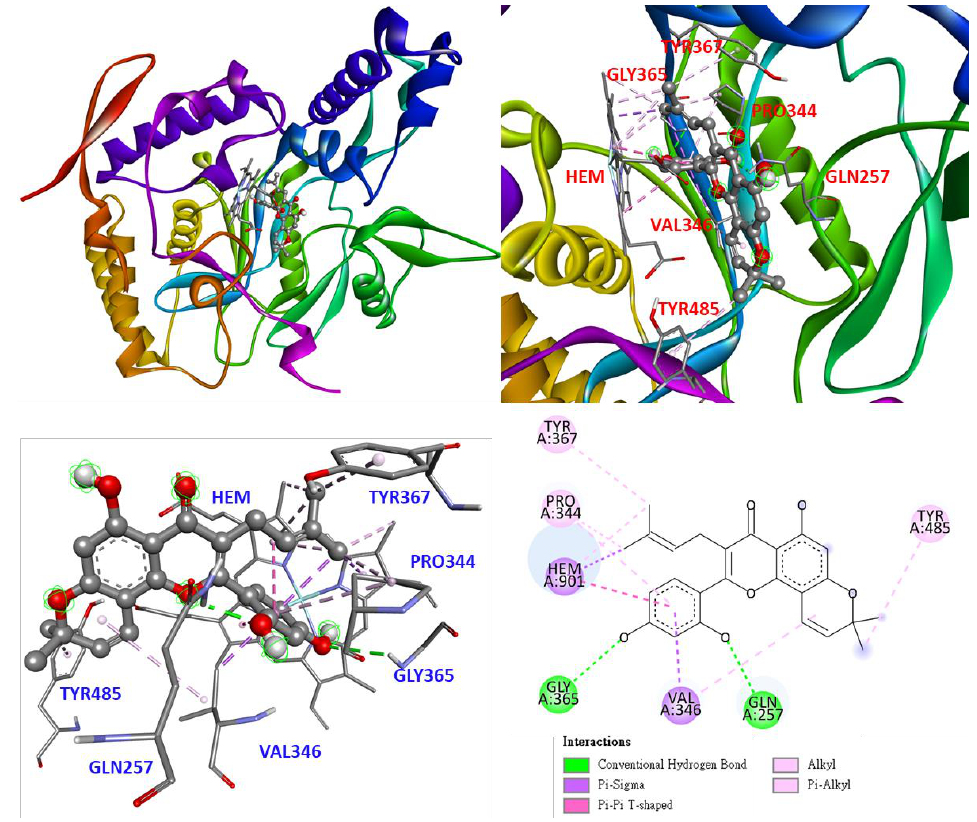
Figure 9. Interaction of morusin ( 2 ) with active sites of Mus musculus iNOS .